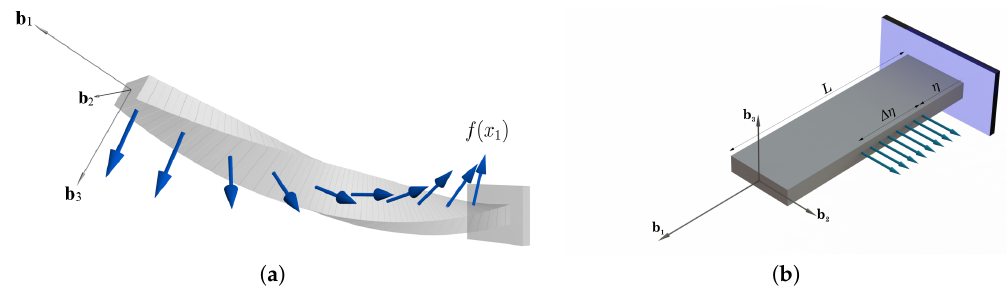
Figure 13. Schematic 3D view of ( a ) Initially curved and twisted beam with ditributed follower force; ( b ) Beam with partially distributed follower force